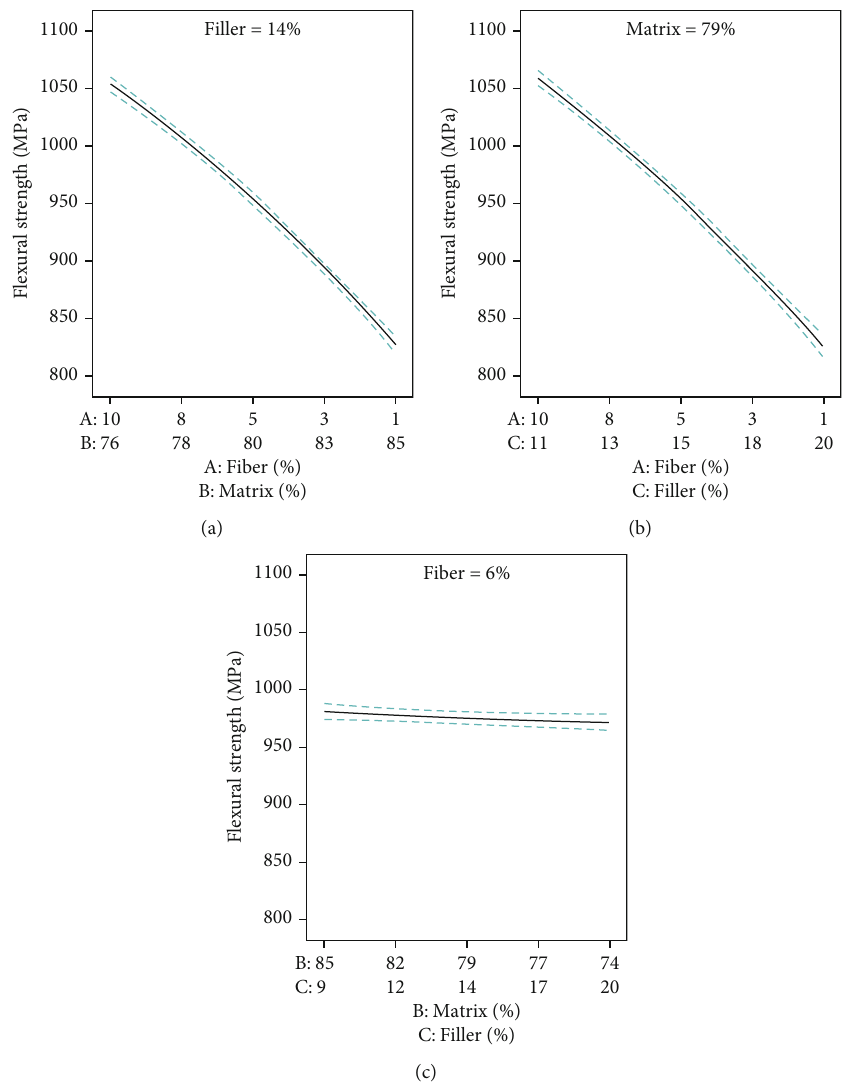
Figure 14: E ff ect of (a) fi ber loading as a function of the matrix, (b) fi ber loading as a function of fi ller, and (c) matrix loading as a function of fi ller on fl exural strength.